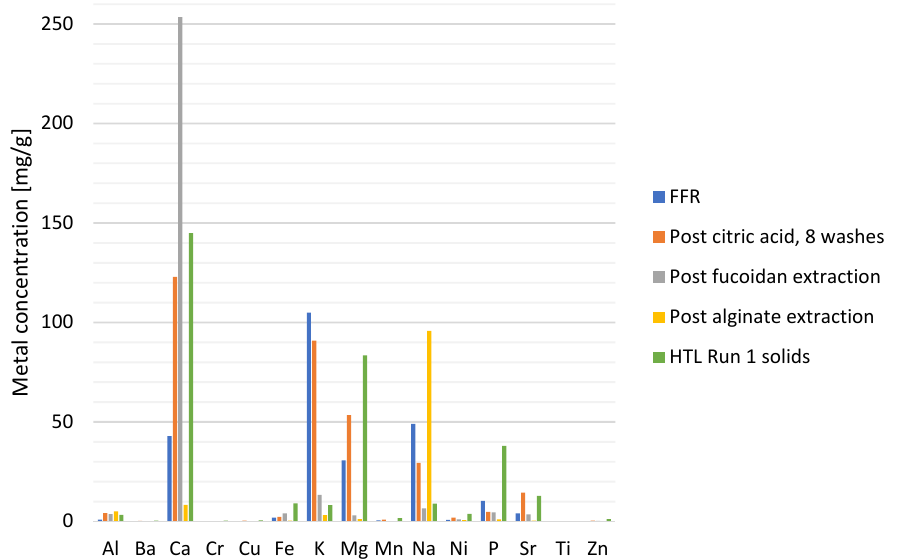
Figure 5. Comparative metal concentrations in raw macroalgae, citric acid leaching, fucoidan, and alginate extraction residues, and the solids produced in HTL run 1, as determined by ICP ash analysis.